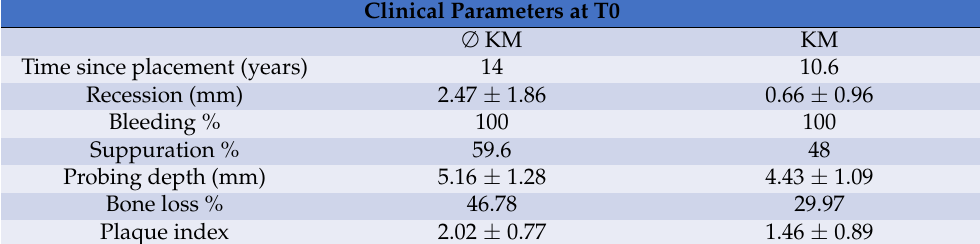
Table 2. Clinical parameters of the implants at T0.